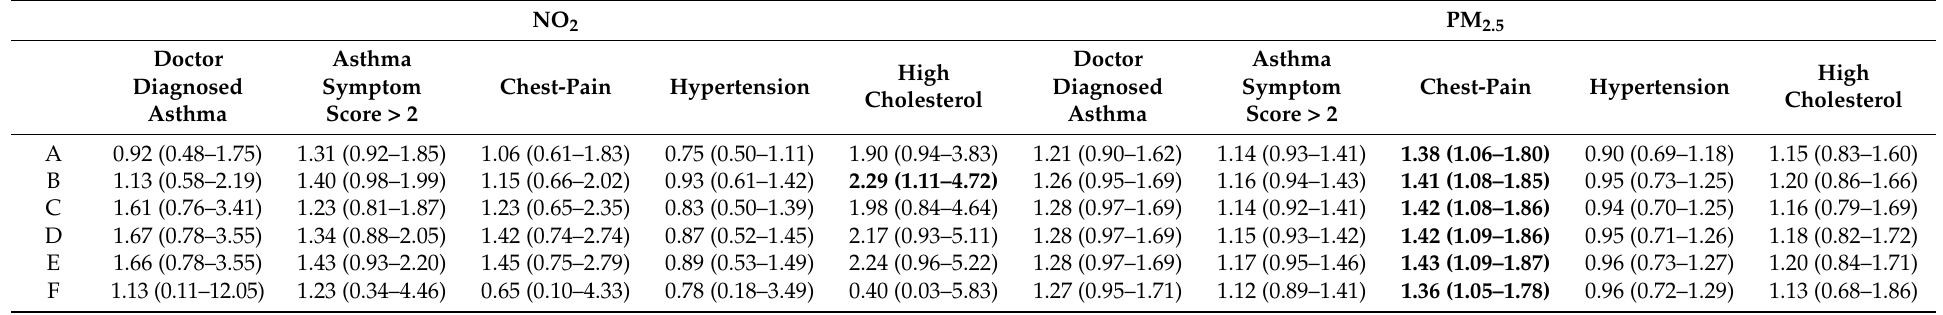
Table 4. Association between interquartile increase in estimated annual NO 2 and PM 2.5 levels and self-reported cardiorespiratory outcomes in single-pollutant model (reported as odds ratios (95% confidence interval).